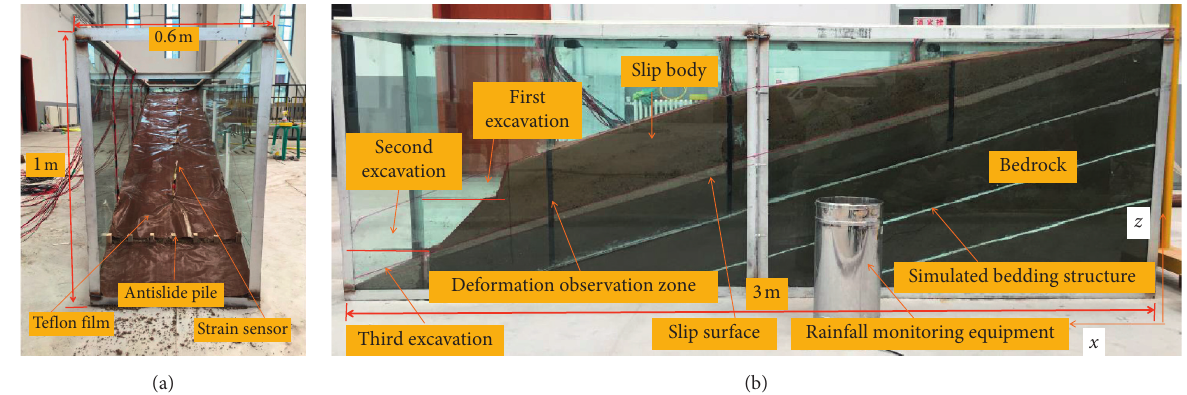
Figure 6: Test model filling. (a) Laying Teflon film. (b) Test model at the end of filling.